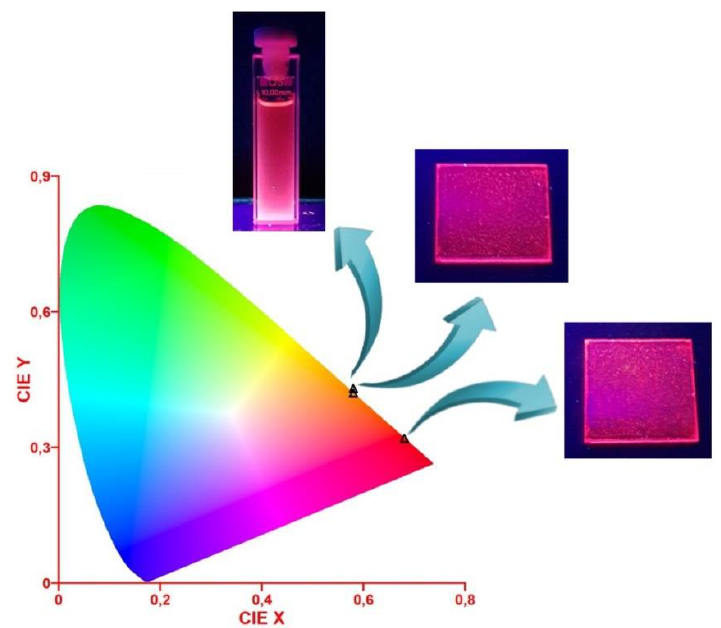
Figure 4. CIE emission diagram of NBDF and of its 30% wt. TCE solution and 25% wt. PVK blend (overlapped). The samples used for CIE calculation in the insets.